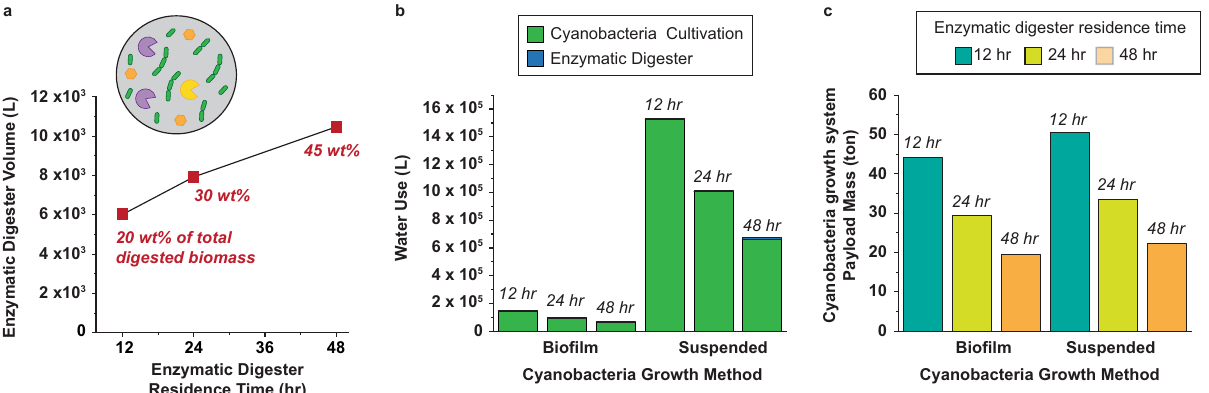
Fig. 5 Cyanobacteria biomass preprocessing metrics required for the bio-ISRU production of 2,3-BDO. a Weight percent of total cyanobacteria biomass digested into glucose depends on the enzymatic digester residence time. The enzymatic digester size increases with increasing residence time. Inset is a cartoon of the enzyme digester composition: cyanobacteria (green), digesting enzymes (yellow, purple), released sugars (orange hexagons). Increasing the enzymatic digester residence time b decreases the volume of water needed and c decreases the payload mass of the cyanobacteria growth system. Results are based on 10 tons of 2,3-BDO produced over 500 sols. Source data underlying b and c are provided as a Source Data fi